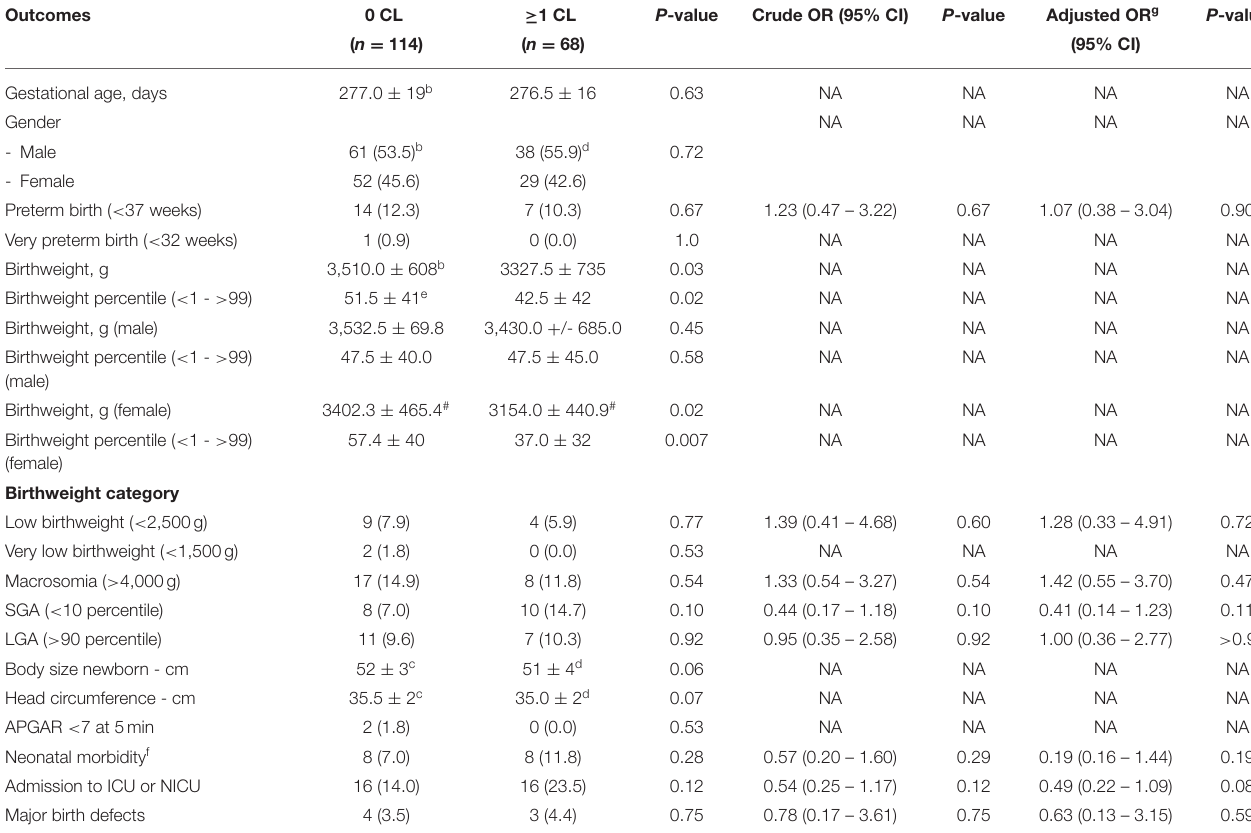
TABLE 4 | Neonatal outcomes in singleton birth after frozen-thawed embryo transfer in the absence (0 CL) or presence ( ≥ 1 CL) of a corpus luteum a . Outcomes 0 CL ≥ 1 CL P -value Crude OR (95% CI) P -value Adjusted OR g P -value